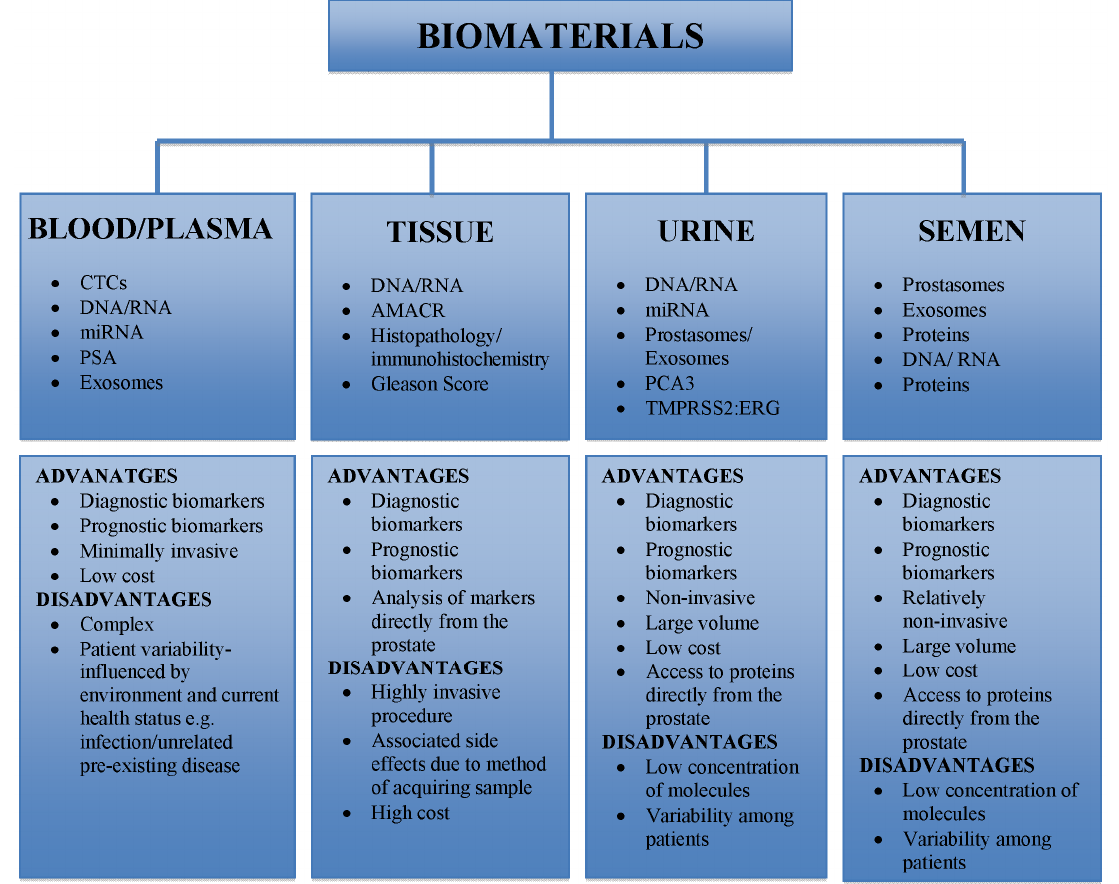
Figure 1. Biomaterials currently available for the identification of prostate cancer biomarkers. Common biological specimens for PCa research include blood, urine, semen and prostate tissue. Each biological sample has associated advantages and disadvantages that may affect clinical validation of biomarkers and adoption for routine testing. Human plasma contains the largest amount of human proteins that could serve as potential markers for PCa diagnosis and prognosis. Urine has become a popular source for proteomic biomarker discovery and analysis due to its non-invasive nature. It contains a vast array of markers that could distinguish between healthy BPH and malignant PCa. Semen is a relatively non-invasive material for analyzing prostate biomarkers. Proteins directly from the prostate are easily accessed; however, there is a compositional variability among patients that poses an issue. Finally, prostate tissue, although a rich source of potential PCa biomarkers, is the most invasive of sampling sites. Abbreviations: CTCs, circulating tumor cells; miRNA, micro RNA; AMACR; alpha-methylacyl-CoA